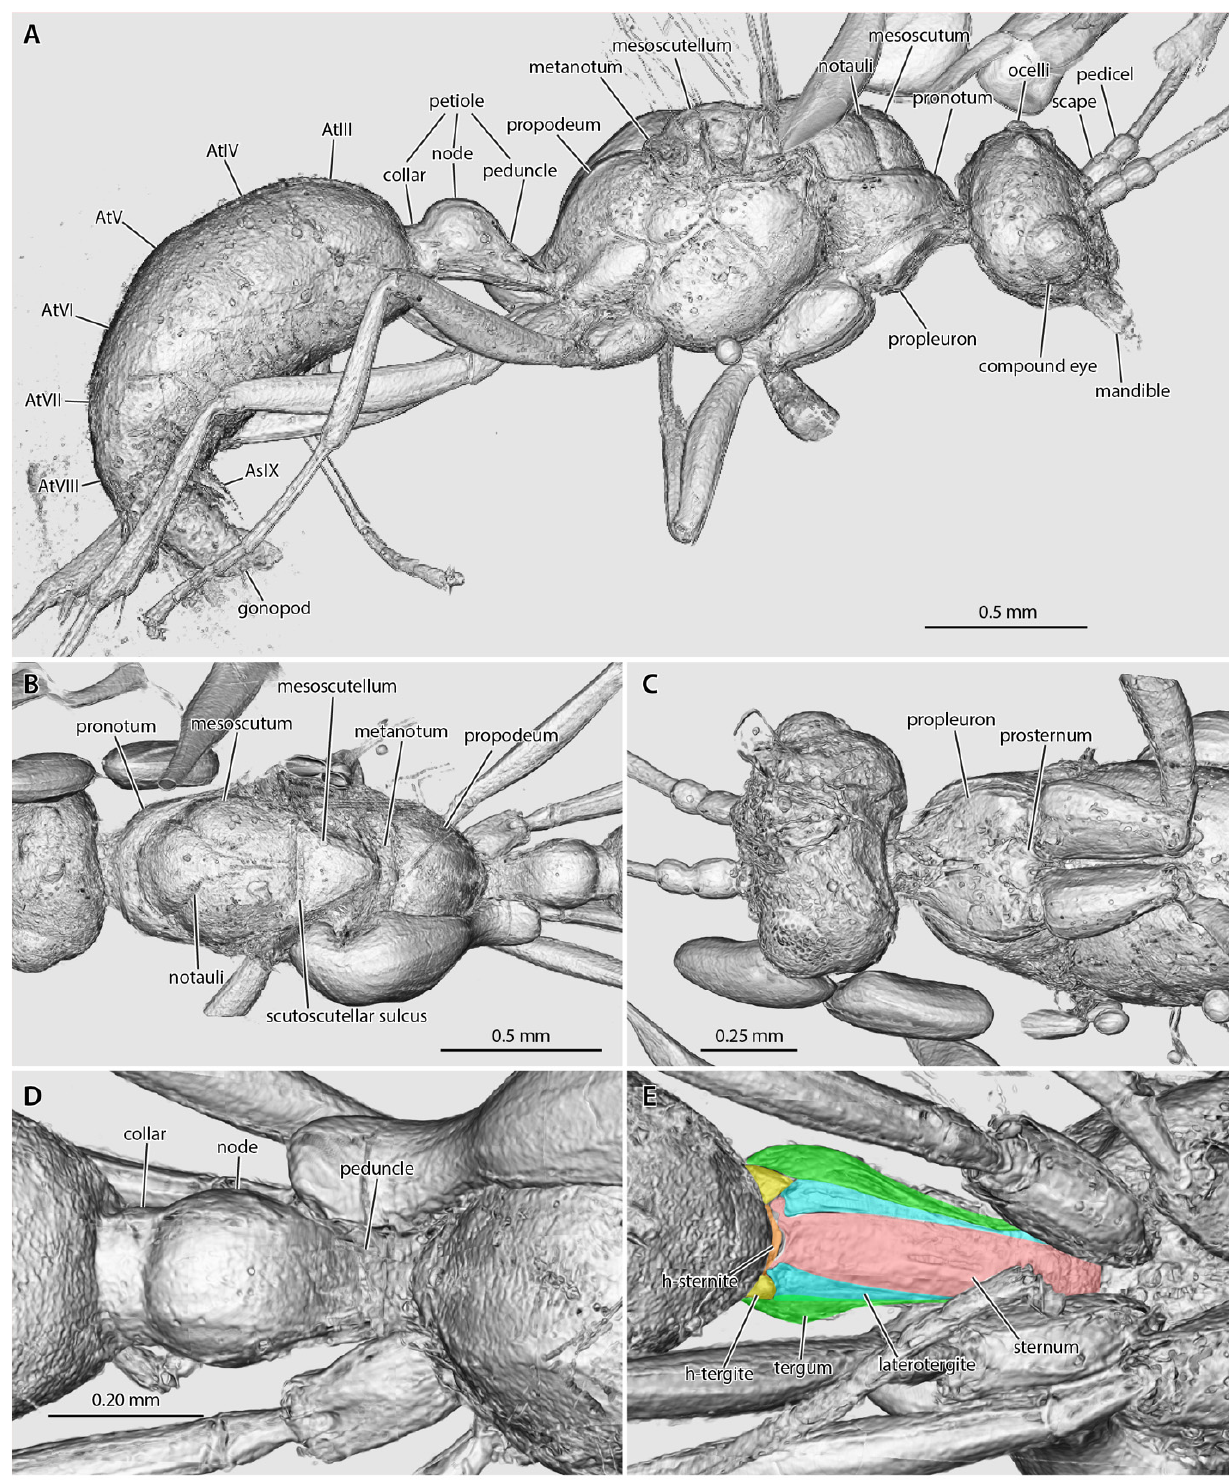
Figure 3. Amira volume renders of the raw data from the † Desyopone hereon gen. et sp. nov. holotype MAIG 6016. ( A ) body in lateral view; ( B ) mesosoma in dorsal view; ( C ) head, prothorax, and mesothorax in ventral view; ( D ) petiole in dorsal view; ( E ) petiole in ventral view, highlighting the petiolar tergum, laterotergites, and sternum, and the helcial tergite and